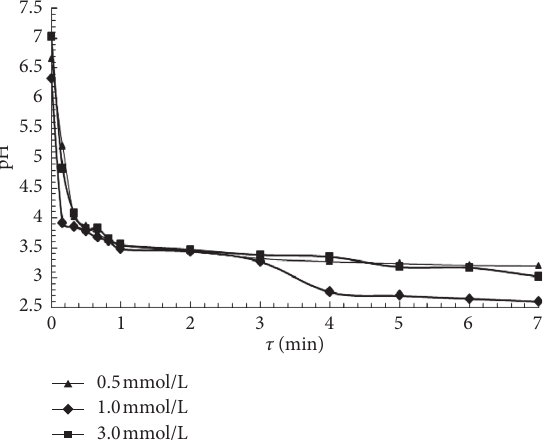
Figure 5: Change in the pH of the solution during the plasma treatment and formation of silver nanoparticles.